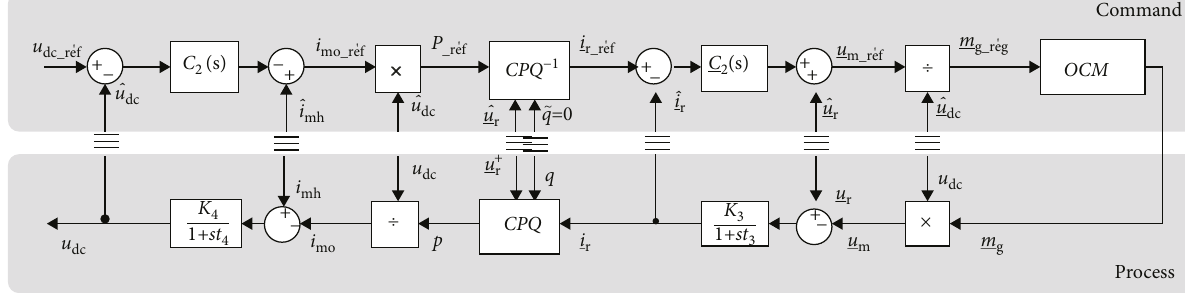
Figure 3: Block diagram of the grid side.